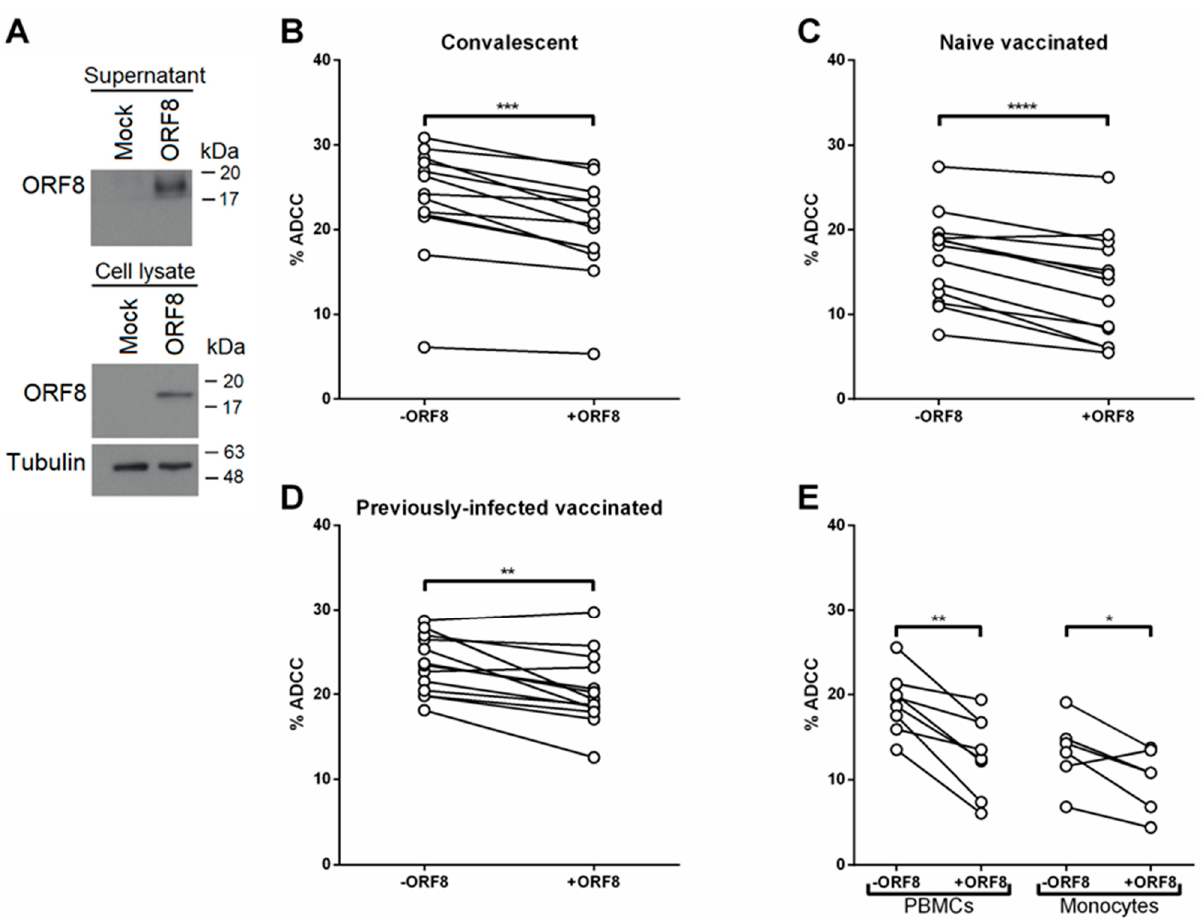
Figure 2. ORF8 decreases PBMC-mediated ADCC. ( A ) Secretion of ORF8 into culture supernatant of HEK293T cells transfected with ORF8 DNA. ORF8 was probed with an anti-ORF8 antibody. ( B ) ADCC (%) mediated by plasma from 13 convalescent individuals, ( C ) 13 vaccinated individuals, and ( D ) 13 previously-infected vaccinated individuals using PBMCs from healthy donors as effector cells. ( E ) ADCC (%) mediated by plasma from convalescent individuals with PBMCs or monocytes as effector cells. The effector cells were treated overnight (16 h) with media from ORF8 DNA-transfected HEK293T cells (+ORF8) or with an identical volume of conditioned media collected from HEK293T cells transfected with a control plasmid ( − ORF8). *, p < 0.05; **, p < 0.01; ***, p < 0.001; ****, p < 0.0001.